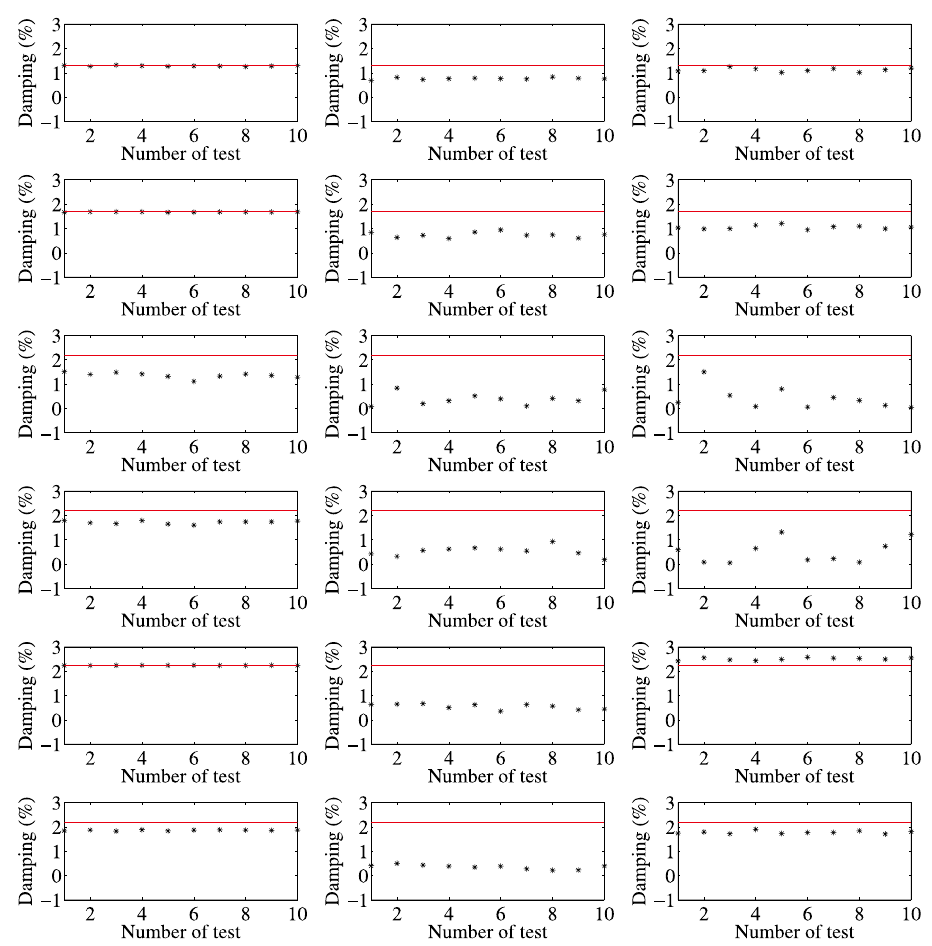
Fig. 6. Damping estimates based on (left) FRFs (middle) power spectra based OMA (right) Transmissibility based OMA.